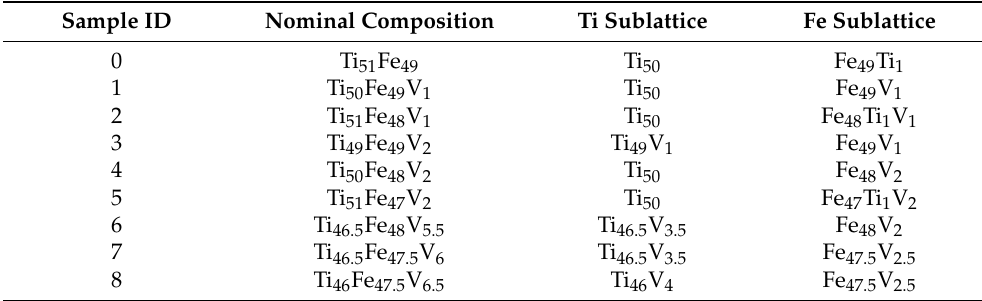
Table 1. Nominal composition of the samples from 0 to 8. The subscripts indicate at% of the corre- sponding elements. Third and fourth columns show atom distribution at the Ti and Fe sublattices. Sample